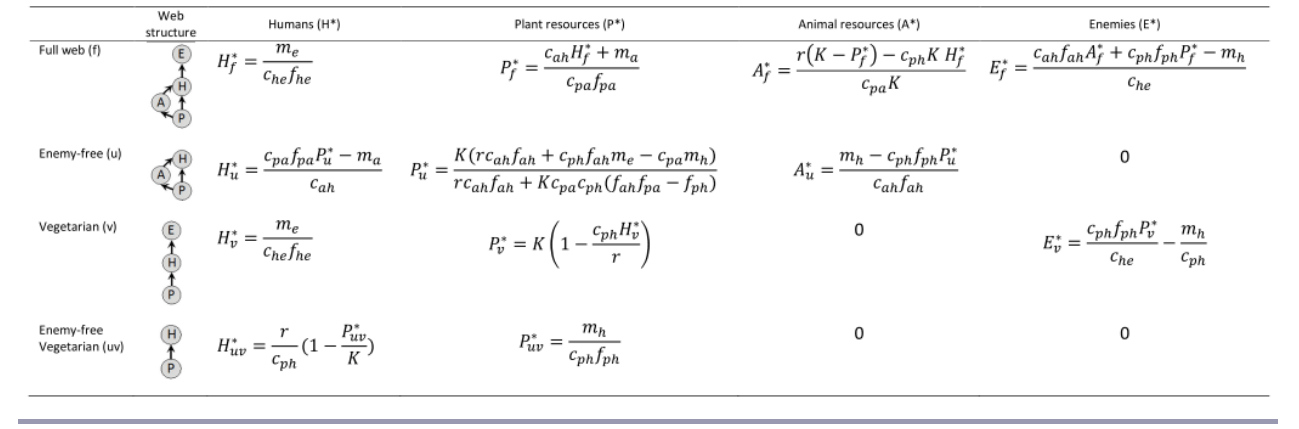
Table 1 . Abundances of humans, plant resources, animal resources, and natural enemies at four equilibriums where humans are